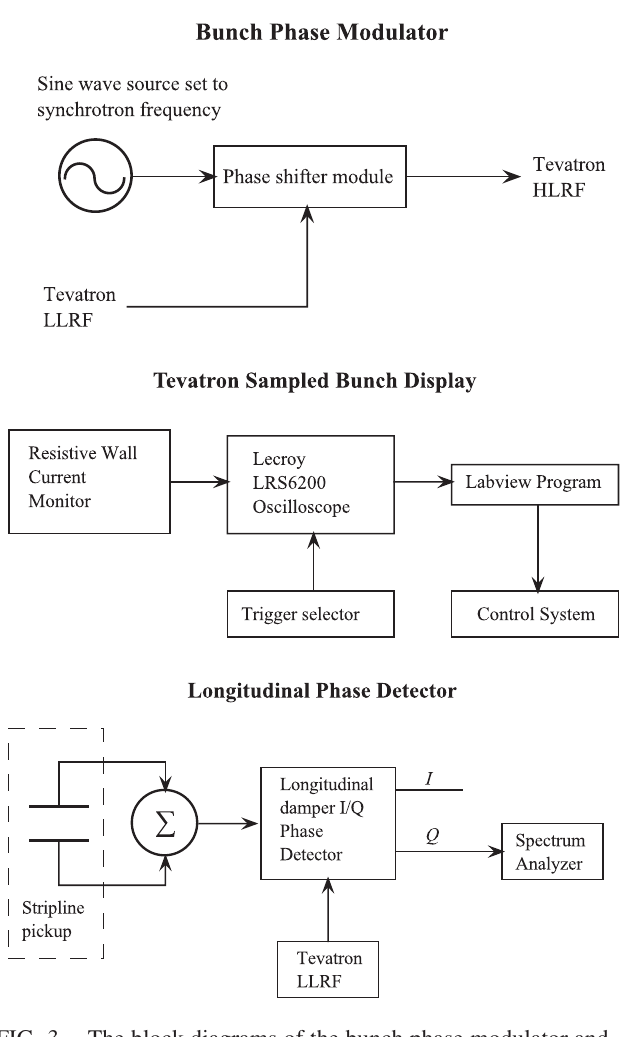
TABLE I. Tevatron parameters relevant to the experiment. Parameter Value